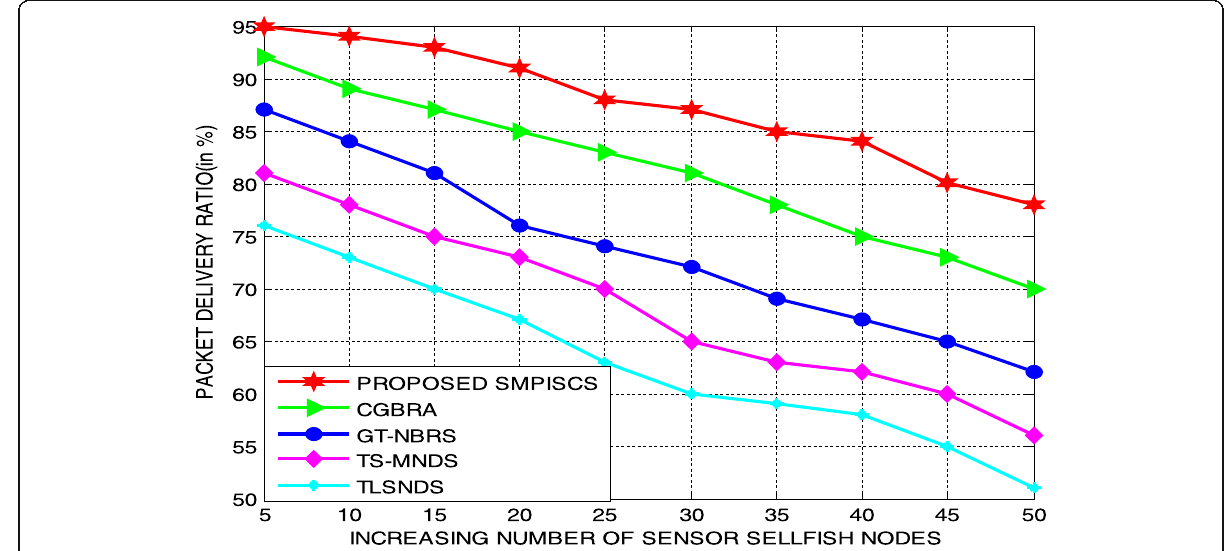
Fig. 7 SMPISCS-Packet Delivery Ratio (with selfish sensor